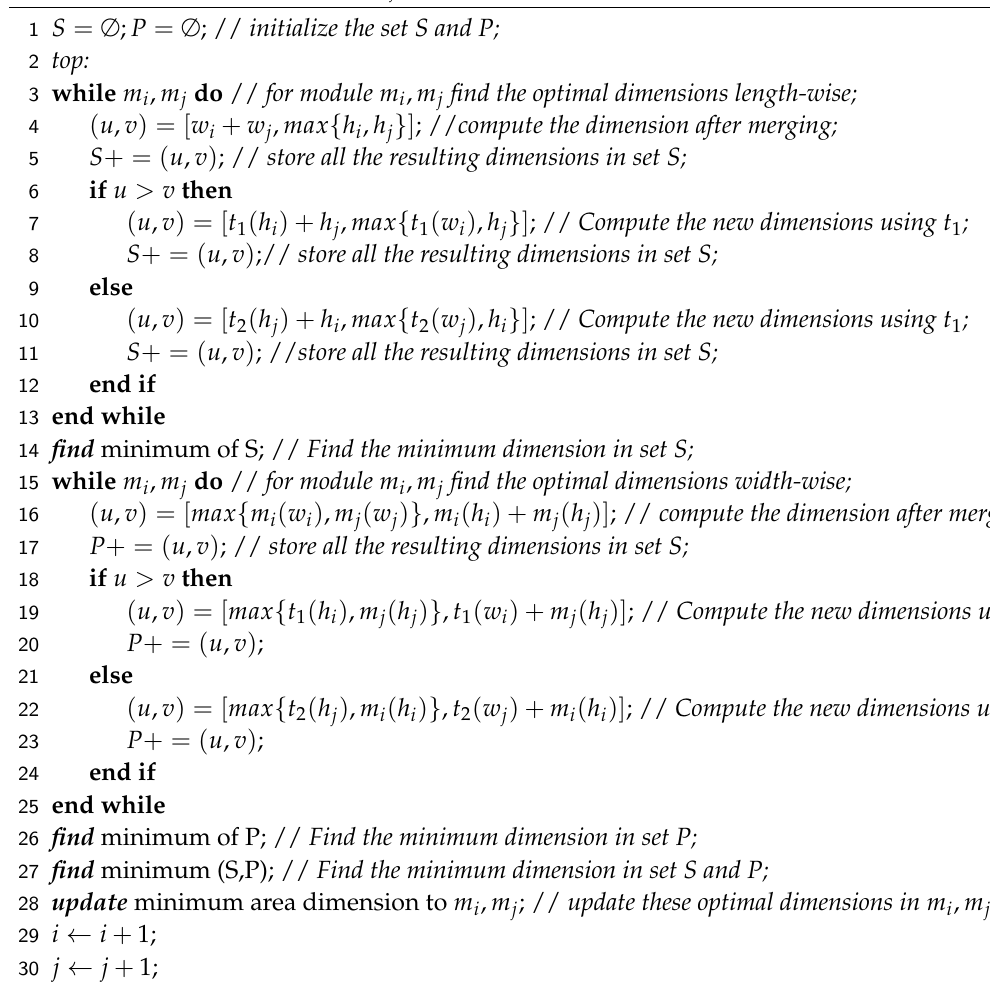
Algorithm 2 Opt_dimension(m i ,m j